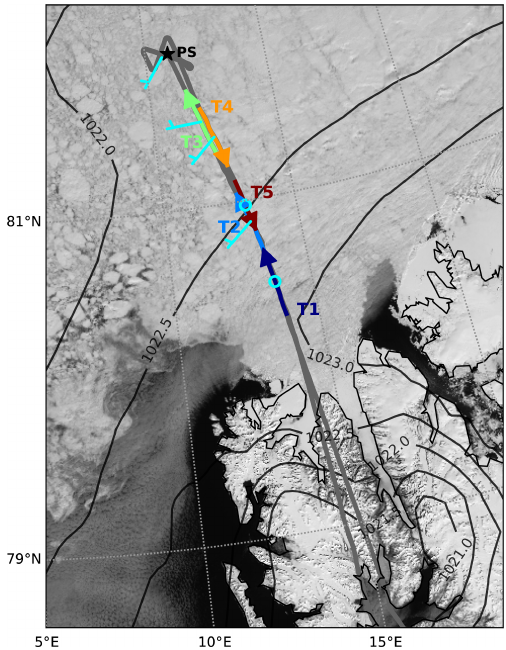
Figure 2. Polar 6 track on 5 June 2017 overlaid over the MODIS satellite image. T1–T5 represent descents and ascents of the aircraft, and PS is the position of RV Polarstern . Wind barbs indicate the ABL averaged wind. The barbs are plotted for wind stronger than 2.5 knots, while weaker wind is indicated by an open circle. Iso- bars represent the mean sea level pressure field based on the ERA5 reanalysis (Hersbach et al.,